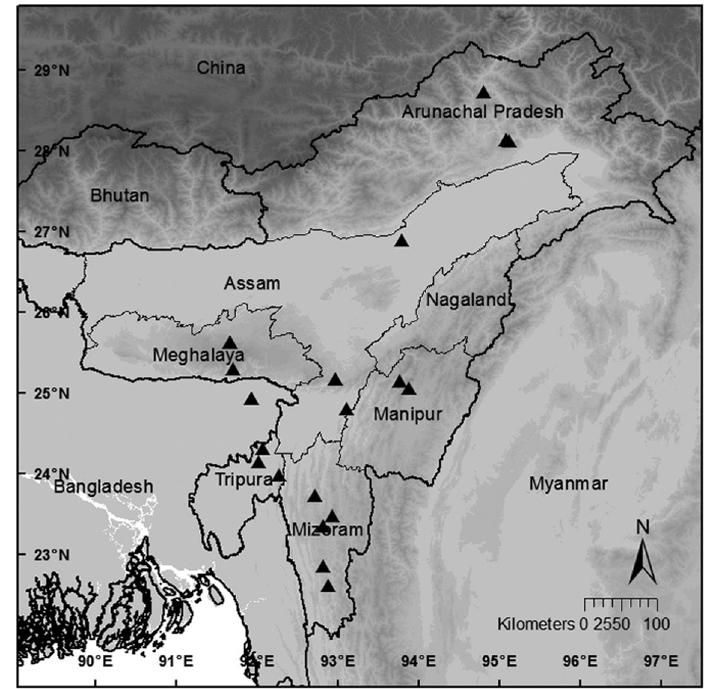
Fig. 60. Map showing the location of B. thomsonii A.DC.